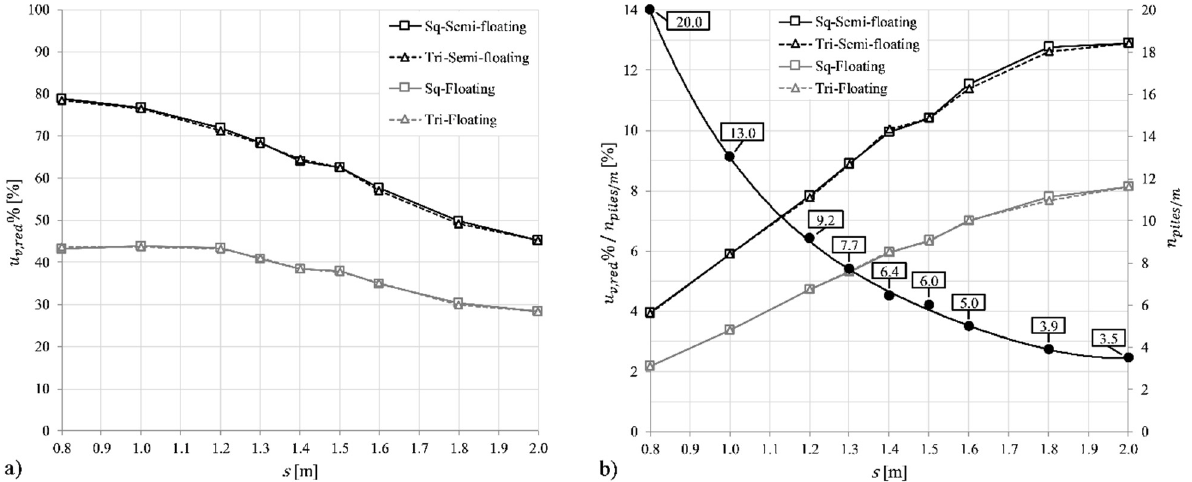
Figure 10. ( a ) average settlement reduction as percentage ( 𝑢 (cid:3049),(cid:3045)(cid:3032)(cid:3031) % ) with increasing 𝑠 and ( b ) ratio of 𝑢 (cid:3049),(cid:3045)(cid:3032)(cid:3031) % to the number of piles per metre of road ( 𝑛 (cid:3043)(cid:3036)(cid:3039)(cid:3032)(cid:3046),(cid:3040) ) with increasing 𝑠 , as well as 𝑛 (cid:3043)(cid:3036)(cid:3039)(cid:3032)(cid:3046),(cid:3040) u v , red % to the number of piles per metre of road ( n piles , m ) with increasing s , as well as n piles , m with with increasing 𝑠 . Square (Sq) and triangular (Tri) pile arrangements. increasing s . Square (Sq) and triangular (Tri) pile